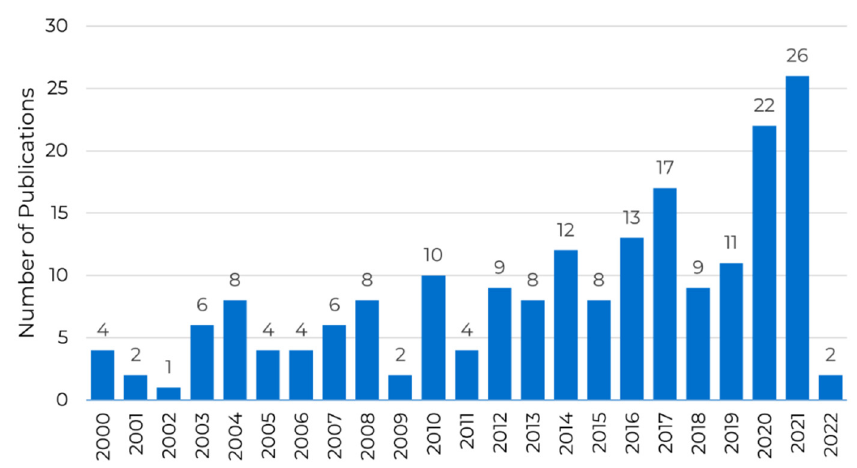
Figure 2. Number of publications per year from 2000 to now, showing the publication trend over the years.